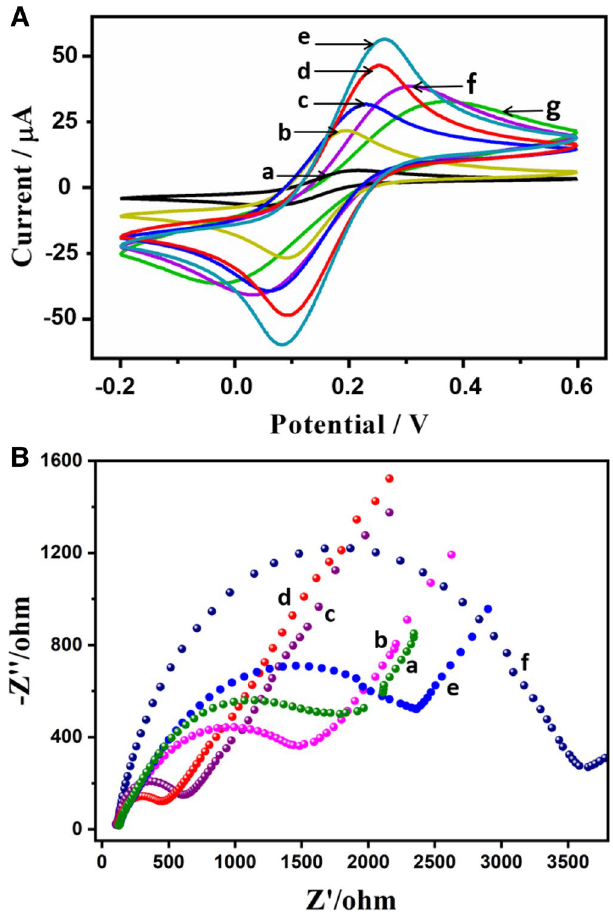
Figure 4. ( A ) Cyclic voltammograms of differentially modified electrodes in 1.0 mM Fe(CN) 6 3−/4− and 0.1 M KCl solution at a scan rate of 100 mV/s. (a) Bare SPCE; (b) Au NPs/SPCE; (c) Au NCs/SPCE; (d) Au NP/ MWCNTs-NH 2 /SPCE; (e) Au NC/MWCNTs-NH 2 /SPCE (f) probe-RNA/Au NC/MWCNTs-NH 2 /SPCE; (g) hybridized-RNA/MWCNTs-NH 2 /SPCE. ( B ) Nyquist diagram of EIS corresponding to each step of the modification of the biosensor. (a) Bare SPCE; (b) Au NPs/SPCE; (c) Au NCs/SPCE; (d) Au NC/MWCNTs-NH 2 / SPCE; (e) probe-RNA/Au NC/MWCNTs-NH 2 /SPCE; (f) hybridized-RNA/MWCNTs-NH 2 /SPCE. The inset displays the Randles circuit to fit the experimental EIS